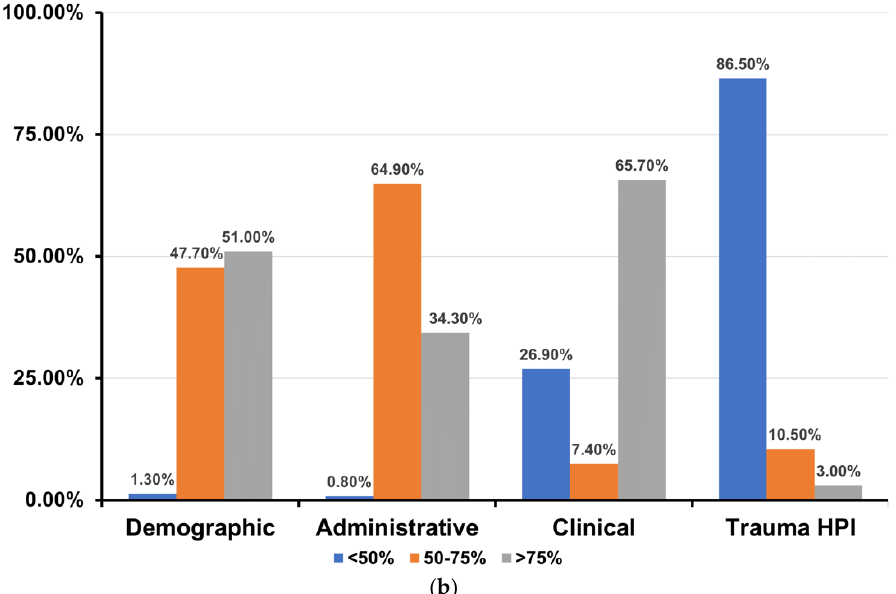
Figure 2. ( a ) Box plot of composite completion rates for the 539 included records. ( b ) Proportion of records with low (<50%), intermediate (50–75%), or high (>75%) levels of completion for each data category. Trauma HPI refers to the history of present illness. This category corresponds to the domain comprising all the data fields describing the cause of trauma and inciting incident.